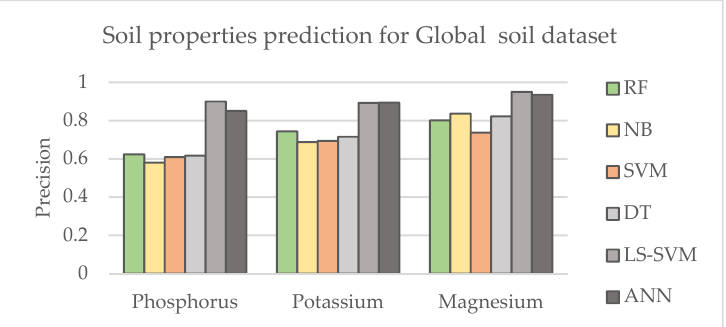
Figure 3. Comparison of the results corresponding to different machine learning techniques for the Global soil dataset using Category II system for category labelling.